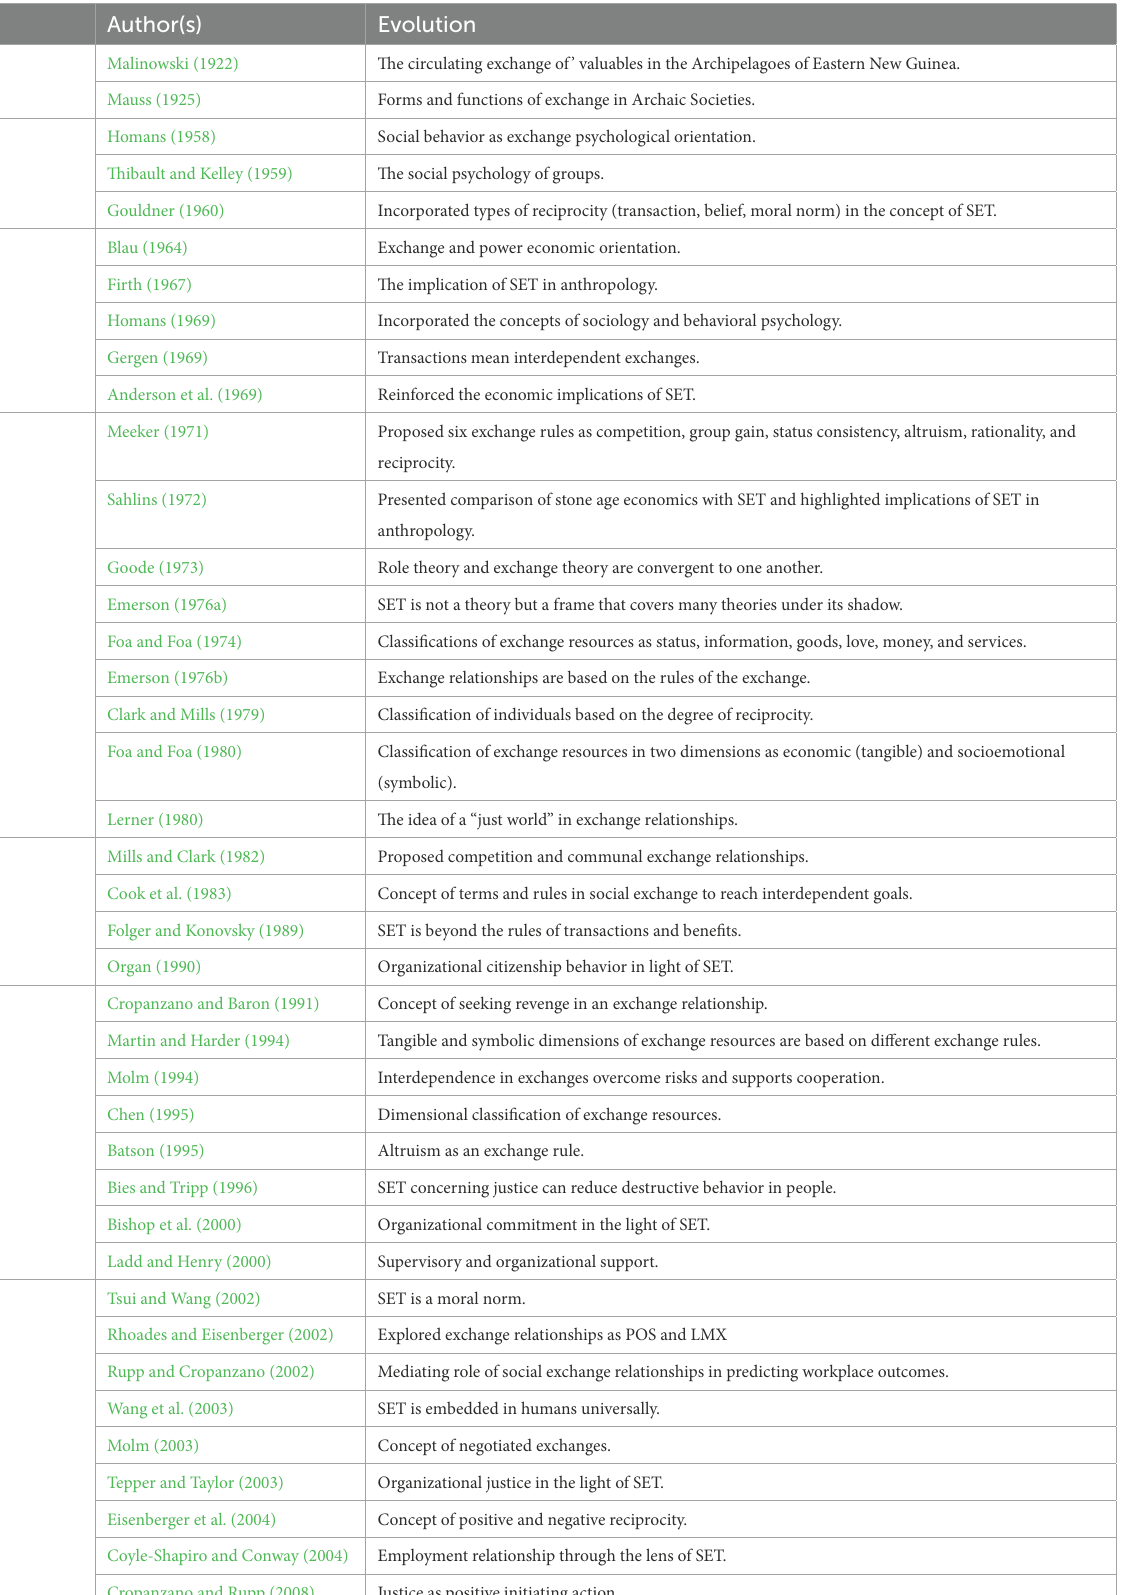
TABLE 1 Evolution of social exchange